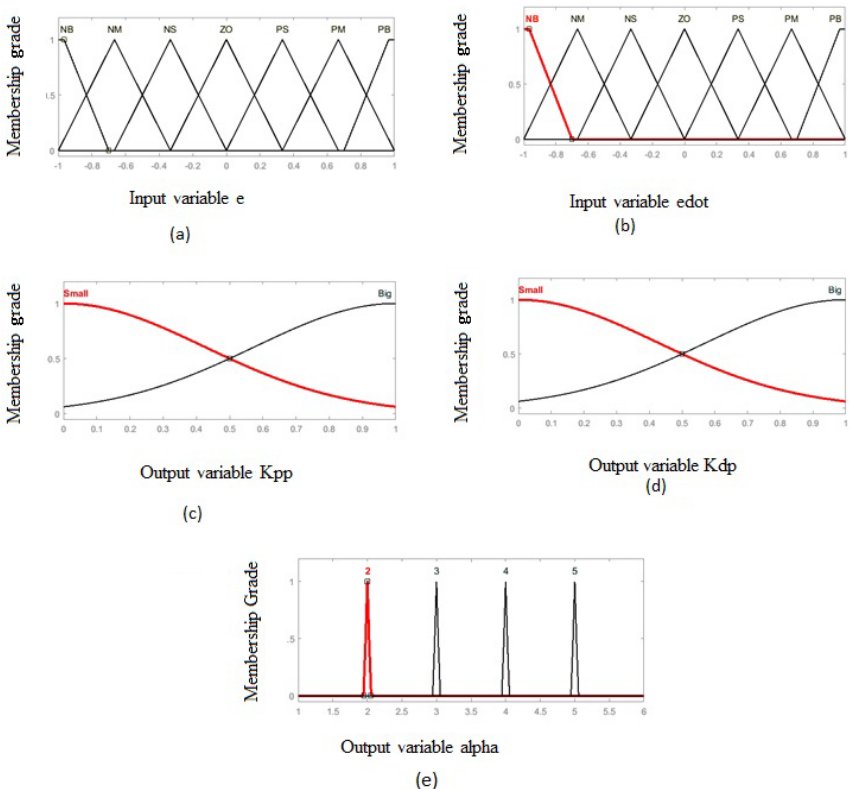
Figure 12. (a) Membership Functions for Input Variable e , (b) Membership Functions for Input Variable edot , (c) Membership Functions for Output Variable K pp , (d) Membership Functions for Output Variable K dp and (e) Membership Functions for Output Variable alpha